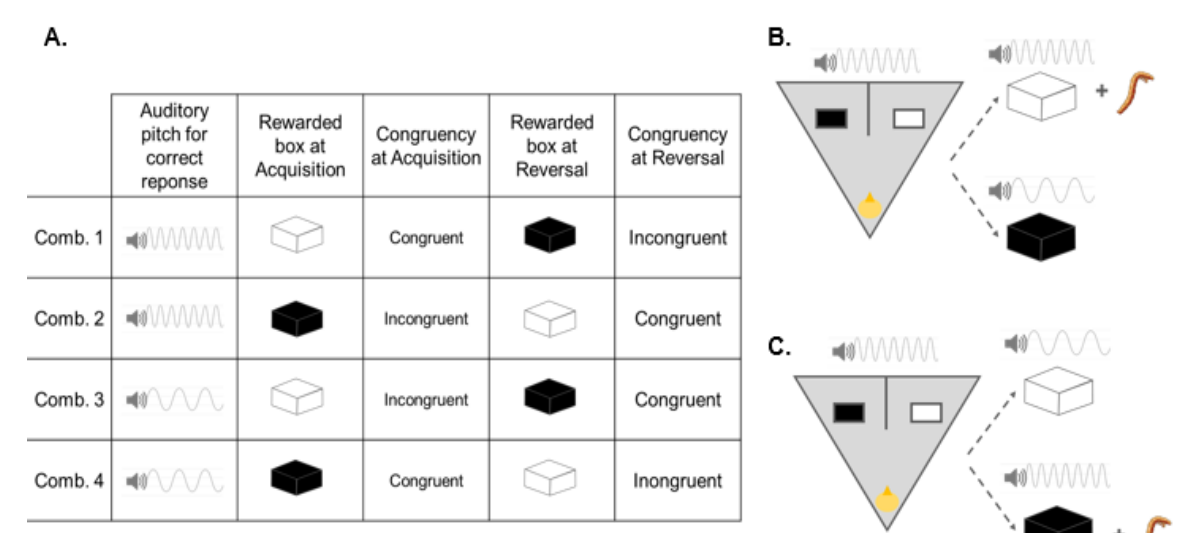
Figure 5. The experimental paradigm used in Experiment 3: ( A ). Chicks were randomly assigned to one of four possible combinations, varying for the luminance of the rewarded box at acquisition (and therefore at reversal) and for the pitch of the sound associated with the reward. In Comb. 1 and Comb. 4, the acquisition presented an association congruent with the pitch–luminance correspondence reported in humans and chimpanzees, while the association became incongruent at reversal. We hypothesized that reversing these two conditions would be harder, as it required chicks to disregard the previously reinforced congruent association and learn an incongruent one. In Comb. 2 and Comb. 3, the acquisition requires an association opposite to the pitch–luminance correspondence reported in human and chimpanzees. However, the association shifts to congruent at reversal. We hypothesized that these two conditions would be easier at reversal, as the chicks are required to disregard an incongruent association in favor of a congruent one. ( B ). Example of the acquisition phase (Comb. 1). ( C ). Example of the reversal phase (Comb.